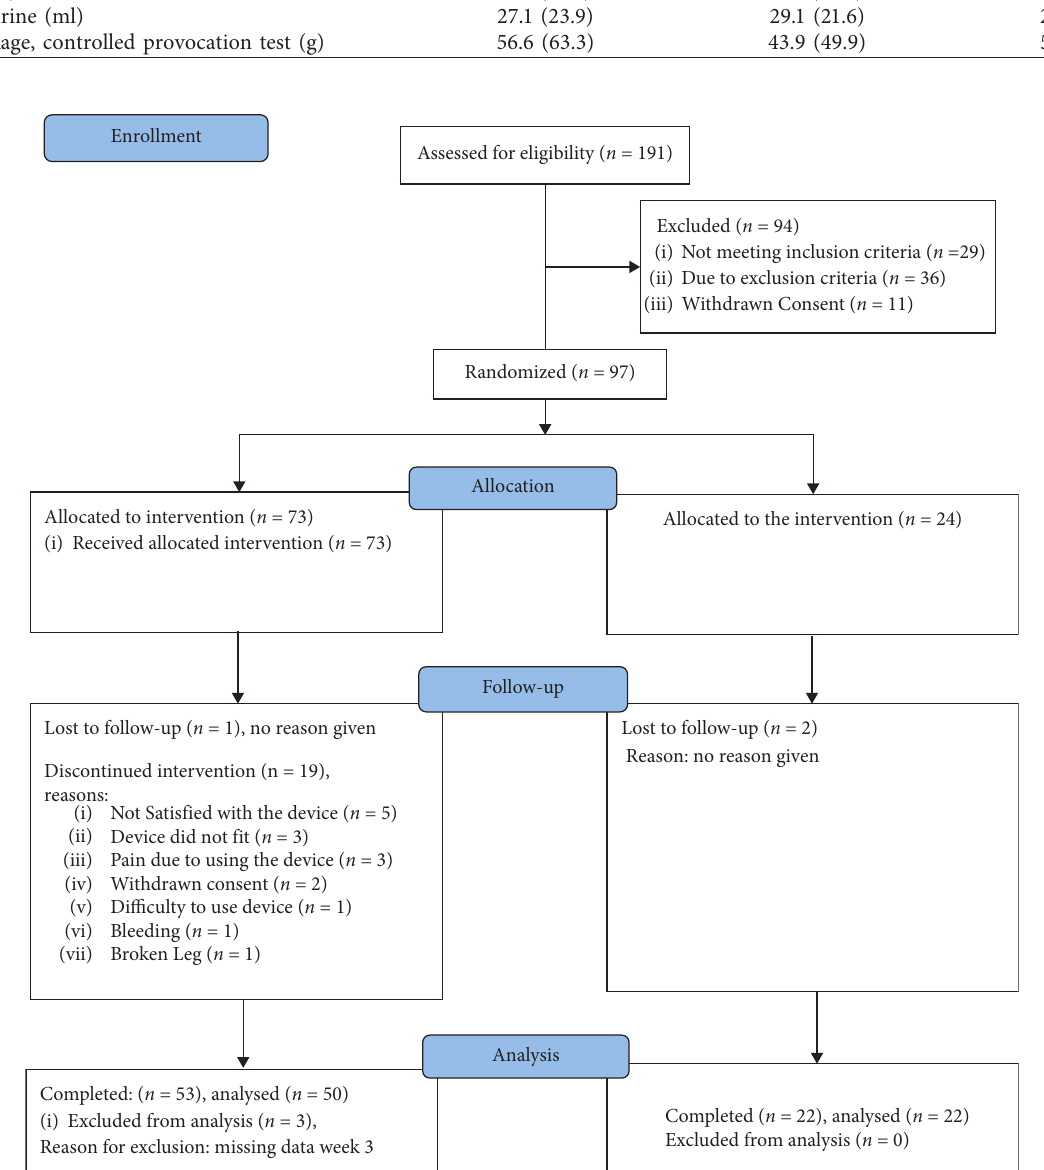
Figure 2: TVS1000 participant